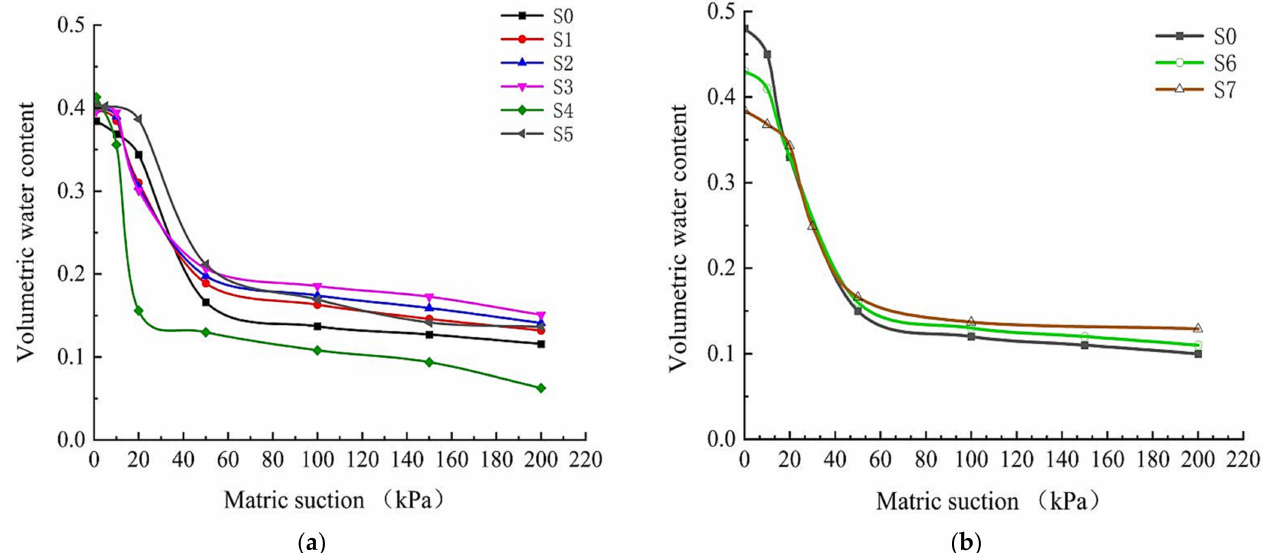
Figure 6. SWCC of loess samples. ( a ) Loess samples with different particle size compositions; ( b ) loess samples with different dry